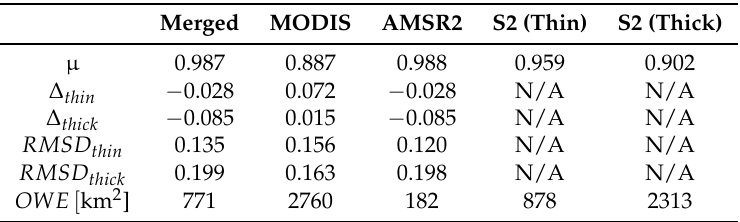
Table 3. Like Table 2, but for the data from Figure 11. All datasets are available for 11,350 out of 11,881 pixels, which yields a surface area of 11,350km 2